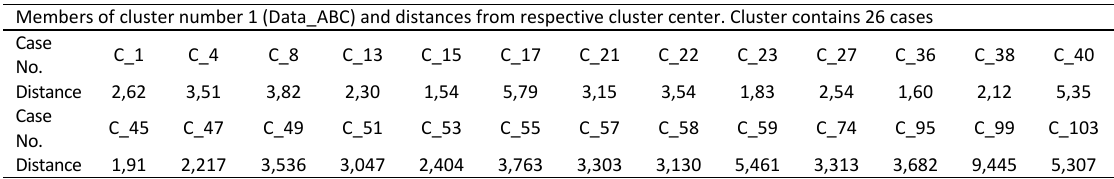
Table 3: The structure of Category A offices group B4 of the KNUTD academic building (STATISTICA 10 listing) Members of cluster number 1 (Data_АВС) and distances from respective cluster center. Cluster contains 26 cases Case No.